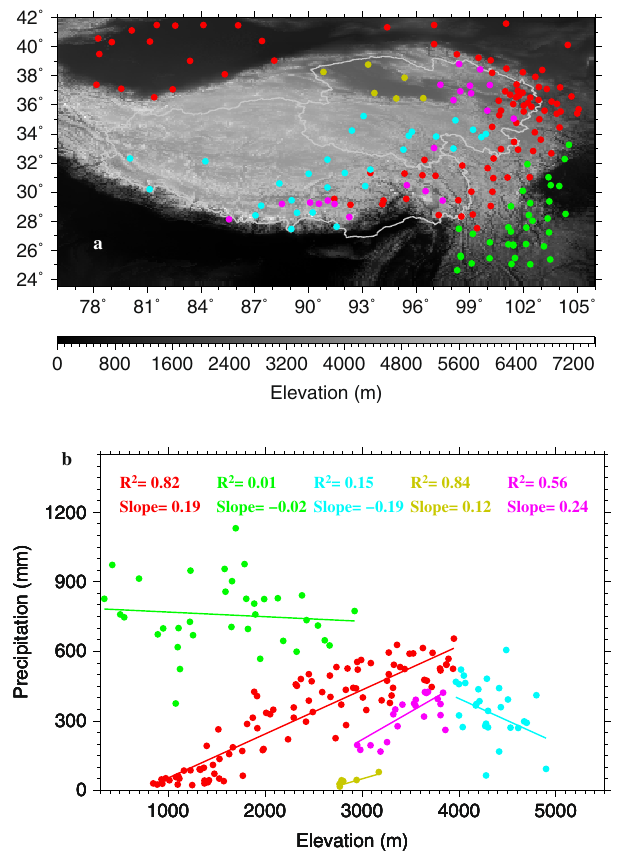
Figure 3. ( a ) Locations of 5 groups of stations that display different precipitation gradients with elevation identified in ( b ) on the TPS. Group Red consists of 94 stations; Group Yellow 6 stations; Group Purple 21 stations; Group Green 35 stations; and Group Blue 28 stations. This figure was plotted using the Generic Mapping Tools (GMT) V4.5.0